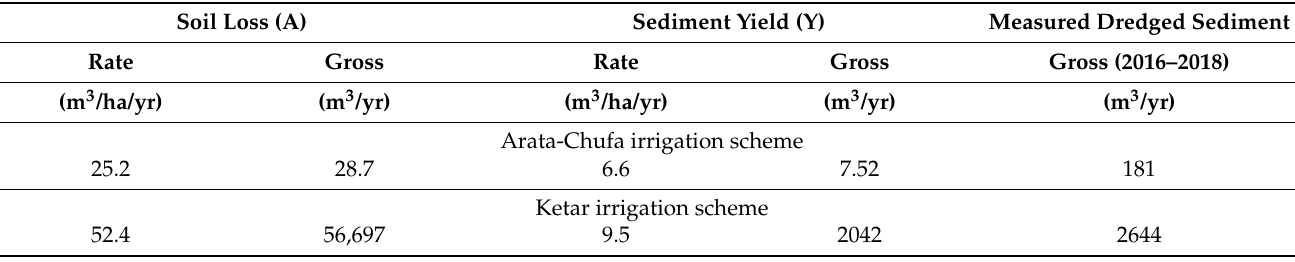
Table 2. Annual soil loss, sediment yield to contributing catchment and quantity of sediment dredged from the main canal of the Arata-Chufa and Ketar